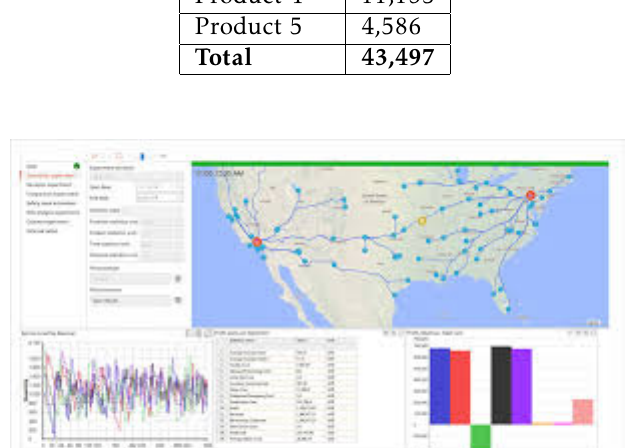
Figure 2. AnyLogistix Software